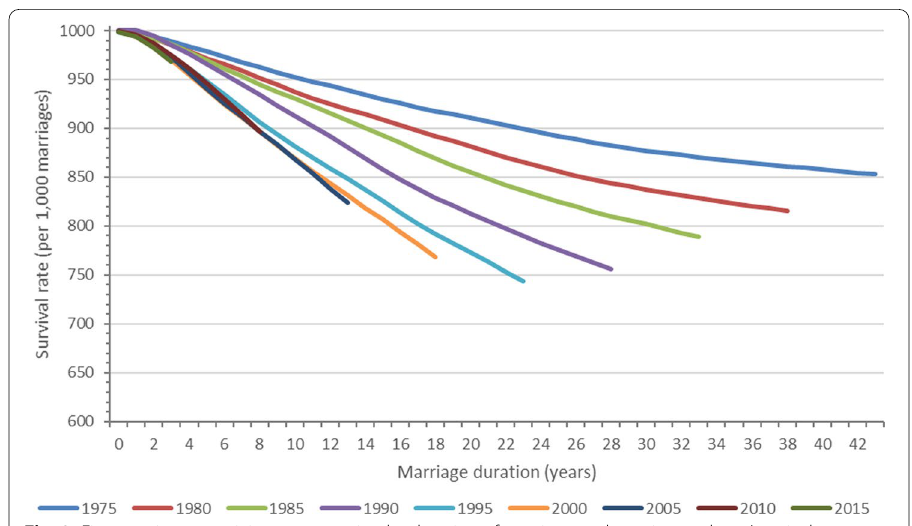
Fig. 3 First marriages surviving at separation by duration of marriage and marriage cohort (survival rates per 1000 marriages), Italy. Source Author’s elaboration of Istat data on marriages and